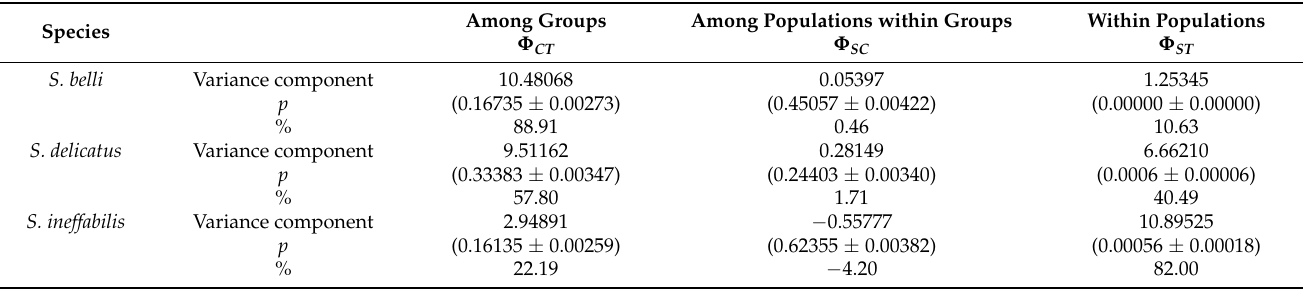
Table 10. Percentage of variation (%) of molecular variance (AMOVA) of different levels of hierarchical population structure for Stereotydeus spp. for the mtDNA cytochrome c oxidase subunit I ( cox1 ). The test was carried out with structure enforced according to geographical regions (see Section 3.3. for